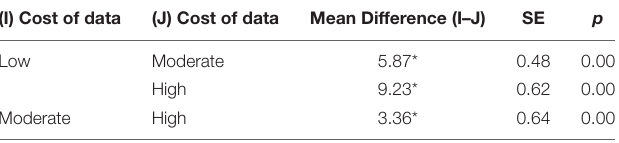
TABLE 4 | Fisher’s LSD test of multiple comparisons of ICT deployment based on the cost of data level among academic staff in public universities.